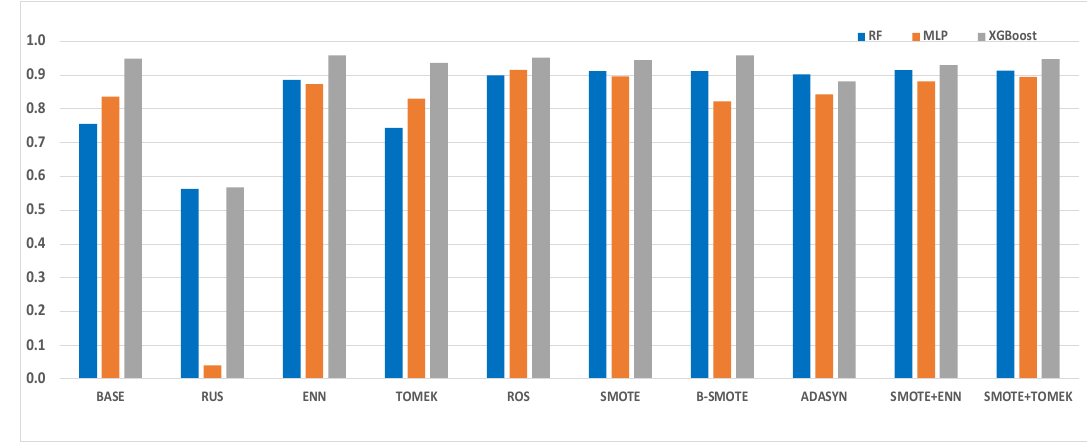
0.00.10.20.30.40.50.60.70.80.91.0 Figure 8. Results of each algorithm before and after sampling ( F 1- score , dataset CSIC2012). Figure 9. Results of the sampling models according to attack data ratio (algorithm RF, F 1- score , dataset PKDD2007). 0.3 Figure 10. Results of sampling models according to data distribution (algorithm RF, F 1- score , dataset CSIC2012). 5. Conclusions and Future Work The class imbalance issue, which is common in the field of intrusion detection, sig- nificantly increases the difficulty of using existing algorithms for classification. In this pa- per, we propose EmSM, which combines a hybrid resampling technique and an ensemble technique to overcome the data imbalance problem in the intrusion detection field. As a result, it was confirmed that the sampling methods had the effect of both binary and multi- 0.2